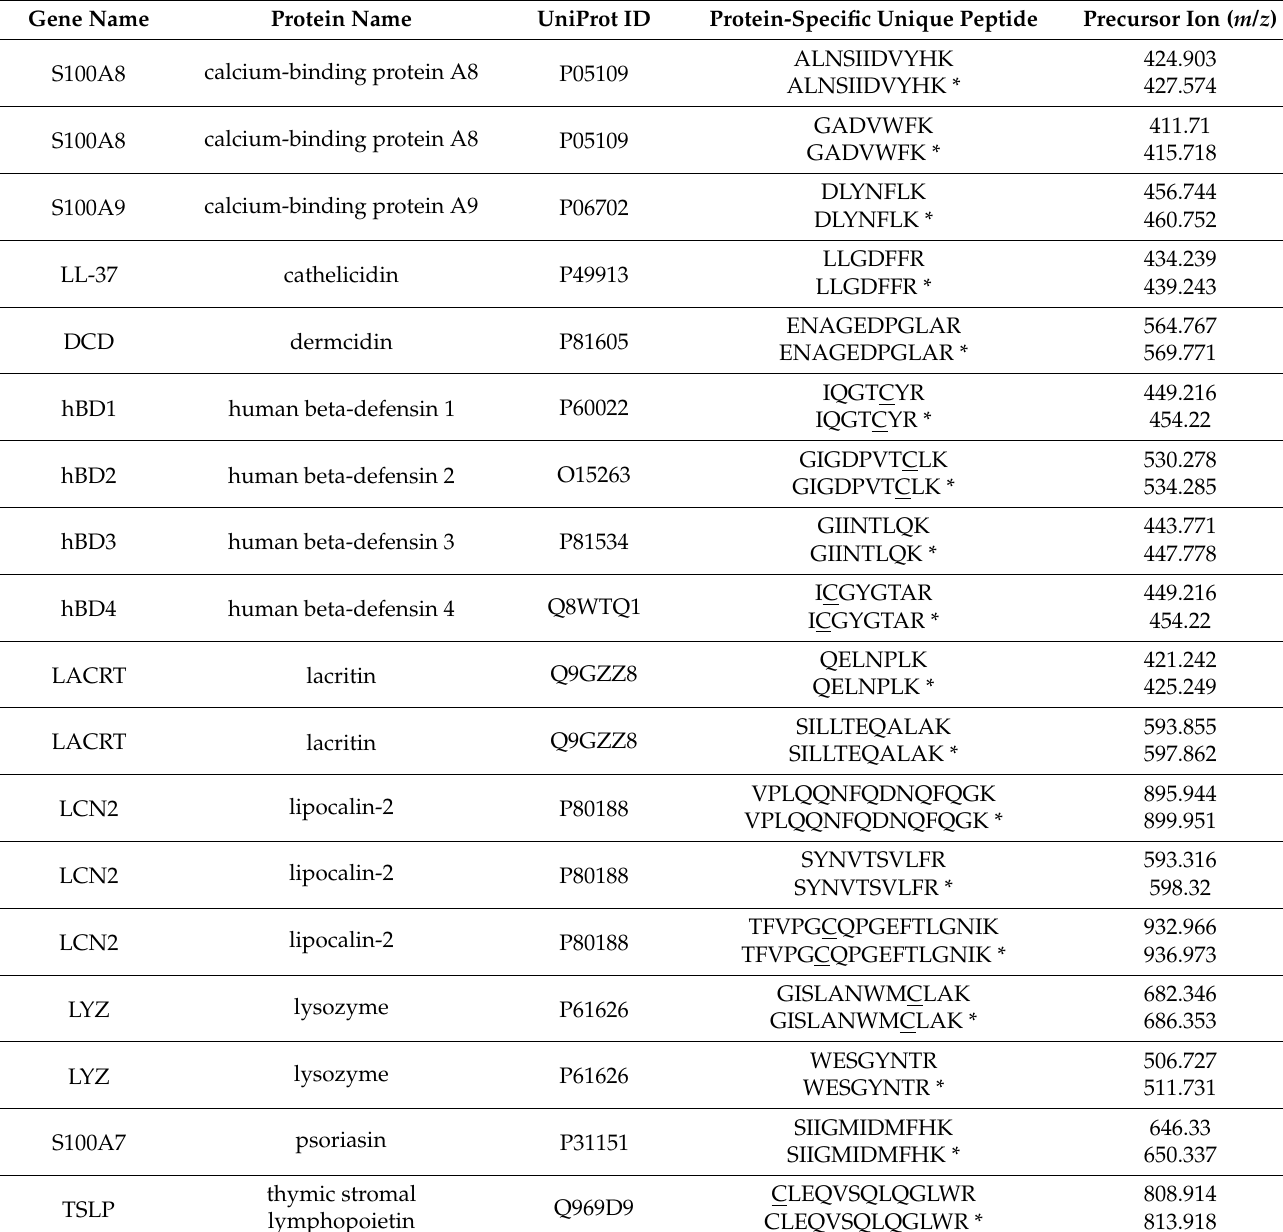
Table 1. List of protein-specific unique peptides characteristic to the examined proteins. The gene name, protein name, UniProt ID, peptide sequence and precursor ion ( m / z ) of each peptide selected for PRM assay are shown. ‘*’ represents the stable isotope-labelled (SIL) amino acids. Underlined C represents carbamidomethylated